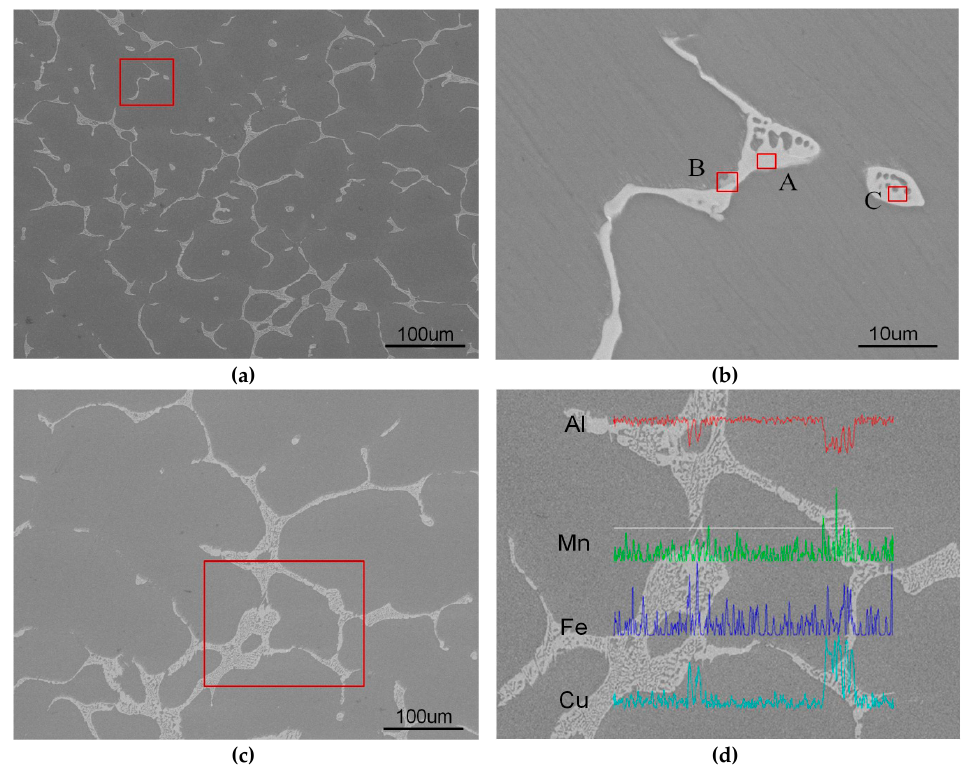
Figure 2. Scanning electron microscopy micrographs of as-cast 2219-6.15Cu and 2219-6.52Cu alloys: ( a , b ) 2219-6.15Cu alloy; ( c , d ) 2219-6.52Cu